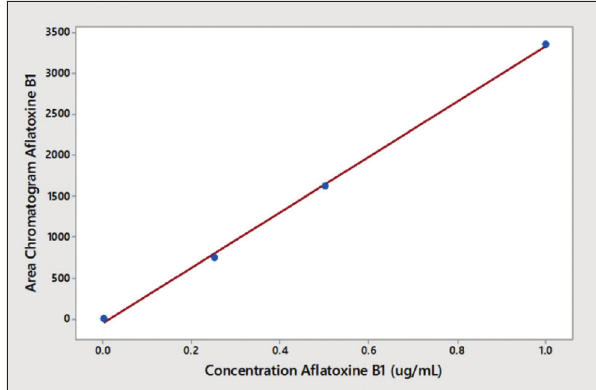
Figure-4: Aflatoxin B (R 2 =0.99).